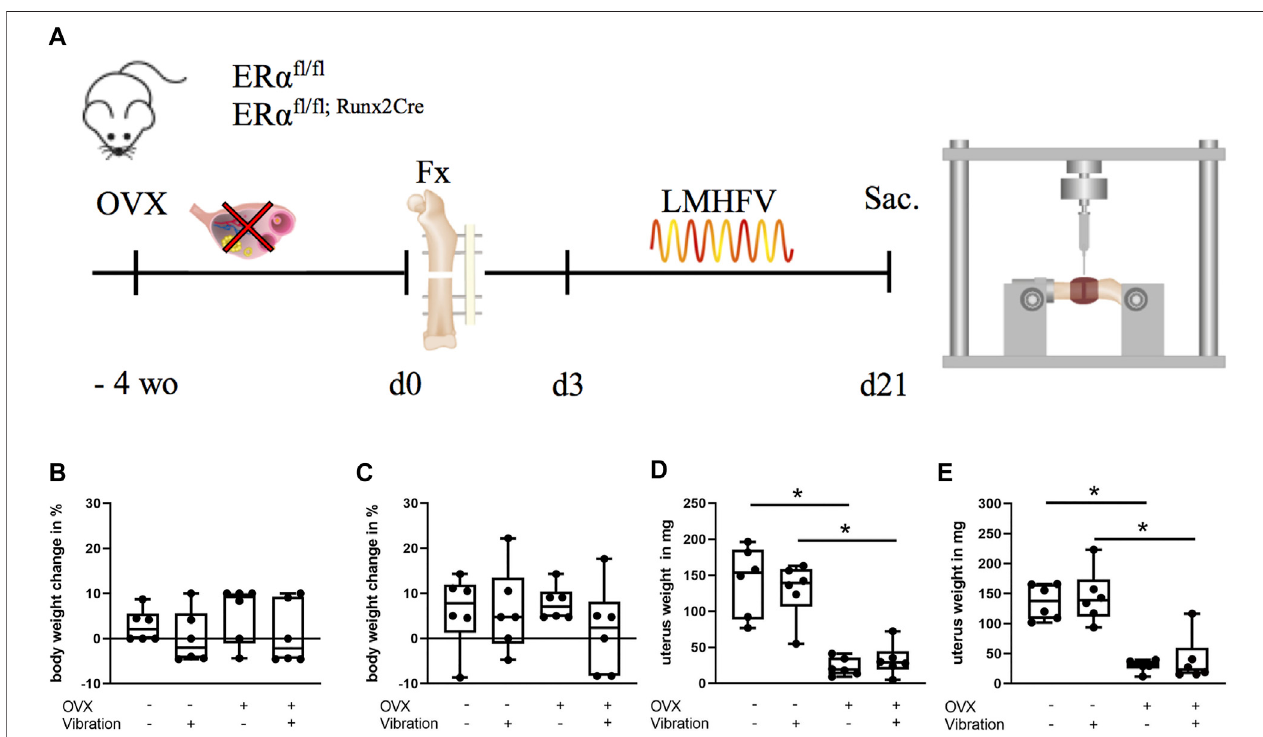
FIGURE 1 | Schematic illustration of the experimental timeline and physiological parameters of ER α fl / fl and ER α fl / fl ; Runx2Cre mice. (A) When aged 12 weeks, mice were ovariectomized (OVX) or sham-operated followed by fracture surgery (Fx) 4 weeks later. Vibration (LMHFV) or sham-vibration treatment started on the third postoperative day for 20 min/day and 5 days/week. On day 21 after fracture, the mice were sacri fi ced (Sac.) and their bones were analyzed. Body weight of ER α fl / fl (B) and ER α fl / fl ; Runx2Cre (C) mice as well as their respective uterus weight [ (D): ER α fl / fl , (E): ER α fl / fl ; Runx2Cre ] was assessed. Data are shown as box-and-whisker plots (with median and interquartile range) from max. to min., showing all data points. *indicates signi fi cant effects with p ≤